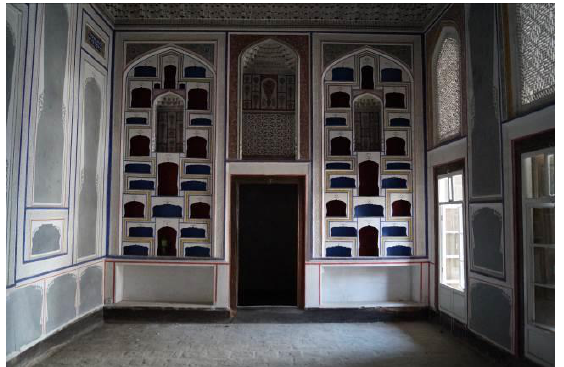
Figure 2. Base plan of Abdullah-bek house in Bukhara. Built by Shirin Muradov. Source: authors based on Voronina (1951)